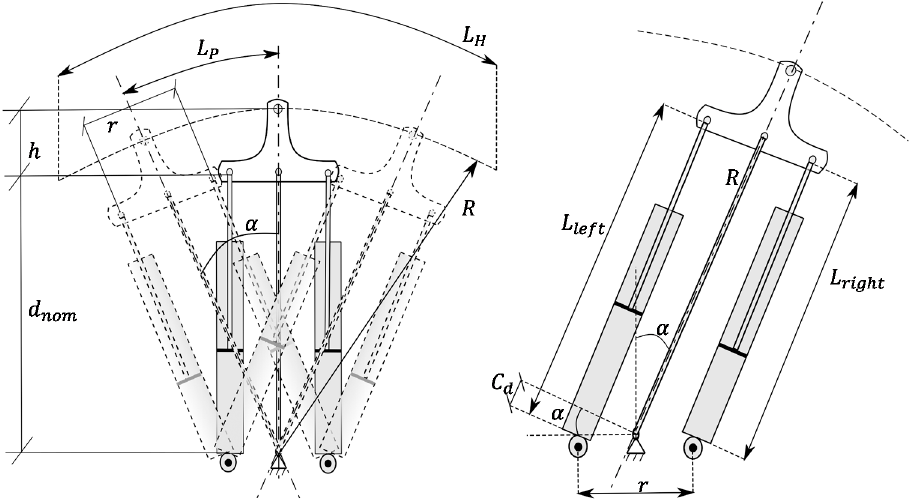
Figure 3. Hydraulic hitch model and its parameters .